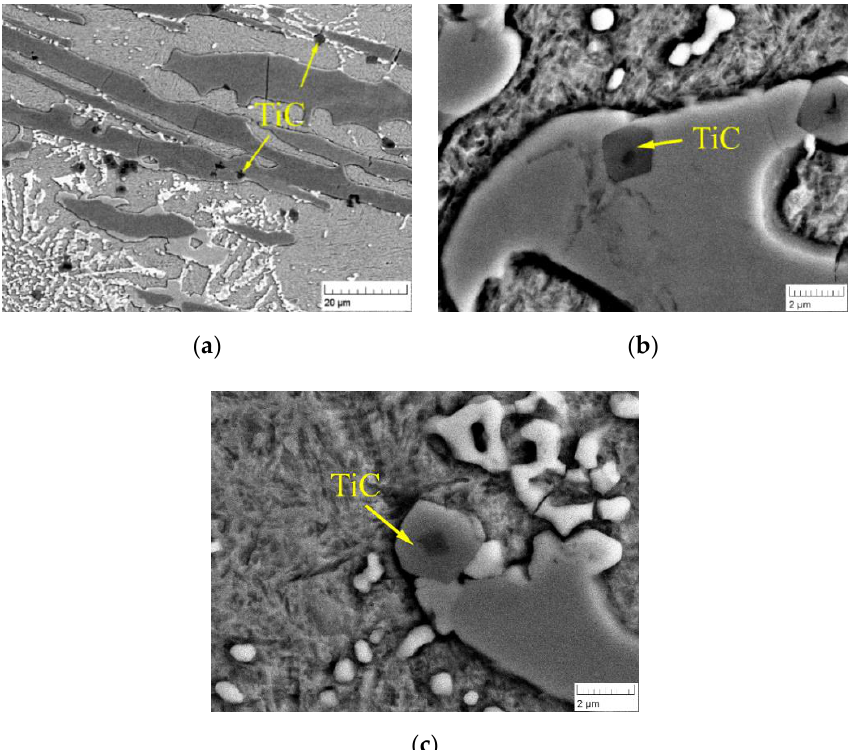
Figure 7. Distribution of TiC particles in heat-treated alloy T2 ( a ), TiC particle inside the borocarbide ( b ) and particle at the interface of matrix and borocarbide ( c ).